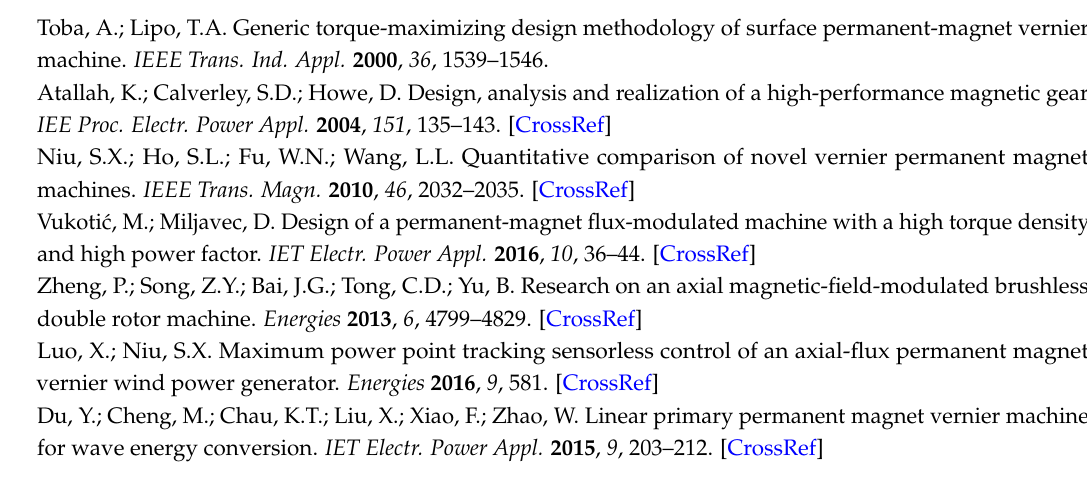
Figure 14. Measured efficiency of prototype machine.